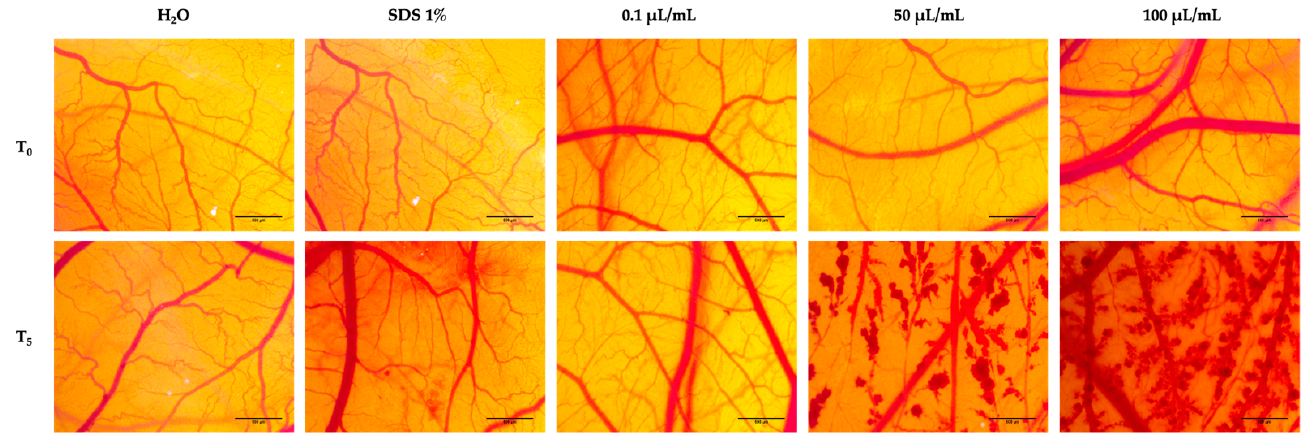
Figure 9. Stereomicroscopic images obtained before the application of the samples (T0) and five minutes after the application (T5) of CAMs inoculated with negative control—H 2 O (distilled water), positive control—SDS (sodium dodecylsulfate), and nicotine at 0.1, 50, and 100 μ L/mL. The scale bars represent 500 μ m.